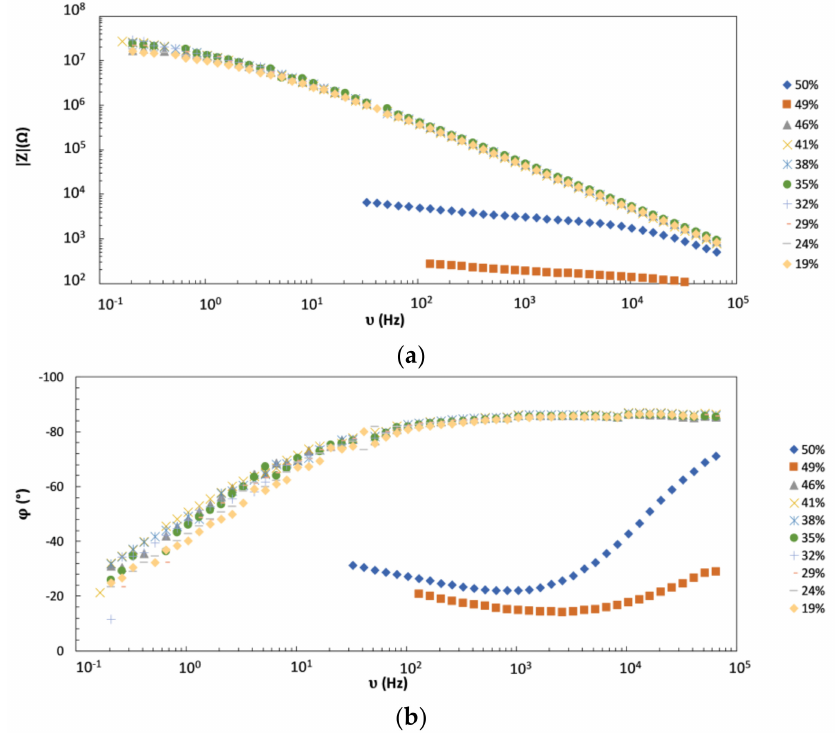
Figure 3. ( a ) Modulus and ( b ) phase angle (Bode diagrams) of the WB talc coatings with various PVCs at 7 days exposure in water condensation